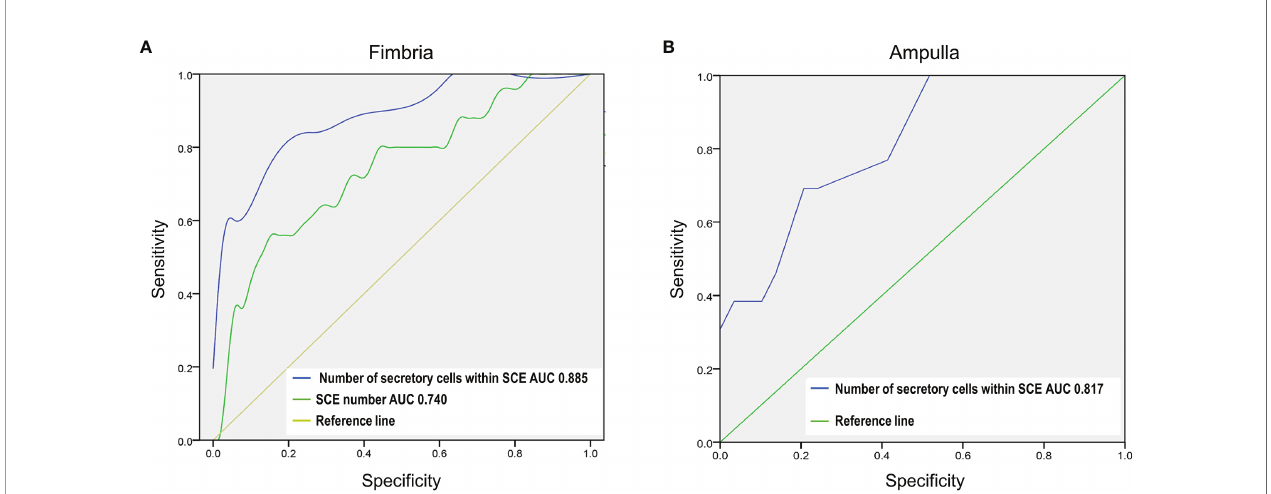
FIGURE 5 | The number of secretory cells within a SCE is a potential biomarker of STIC lesions in the fallopian tube fi mbria and ampulla. The ROC test was used to assess the diagnostic potential of global fallopian tube histopathology in identifying fallopian tubes with STIC lesions (STIC vs Benign+NoSTIC). (A) ROC curve analysis of the relative number of SCE and the number of secretory cells within SCE in the fi mbria region. (B) ROC curve analysis of the number of secretory cells within SCE in the ampulla region.